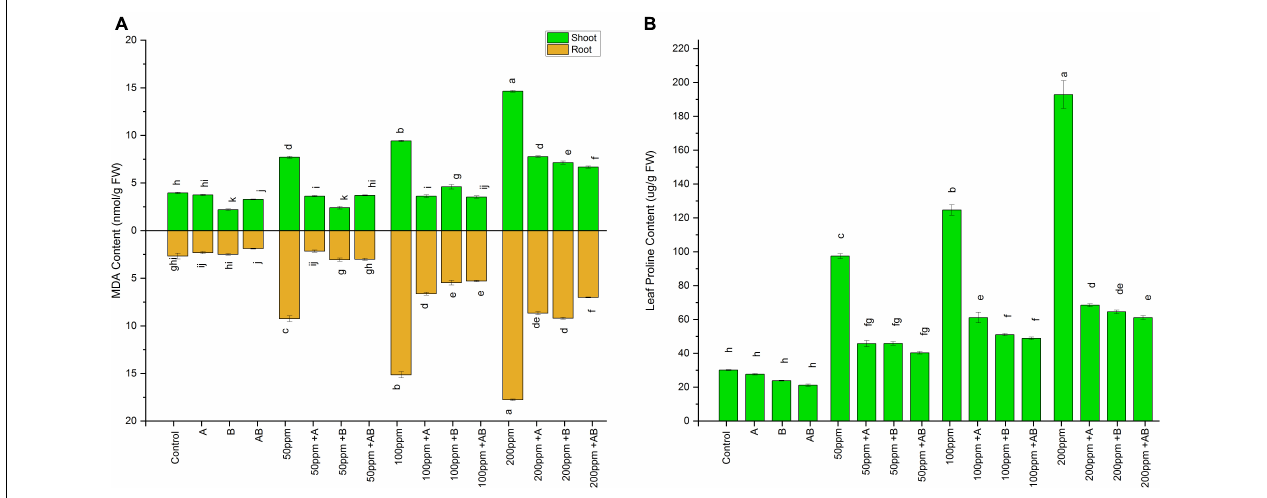
FIGURE 5 | Effect of heavy metal–resistant plant growth–promoting bacteria on (A) MDA and (B) proline activity of wheat ( Triticum aestivum L.) in plants under control and heavy metal (Cd, Ni, Pb) stress conditions. Values are the mean of three replicates. Bars represent the standard error of means. Different letters above the bars indicate statistically significant difference between treatments at P ≤ 0.05. Details of treatments are the same as those in Figure 1 .